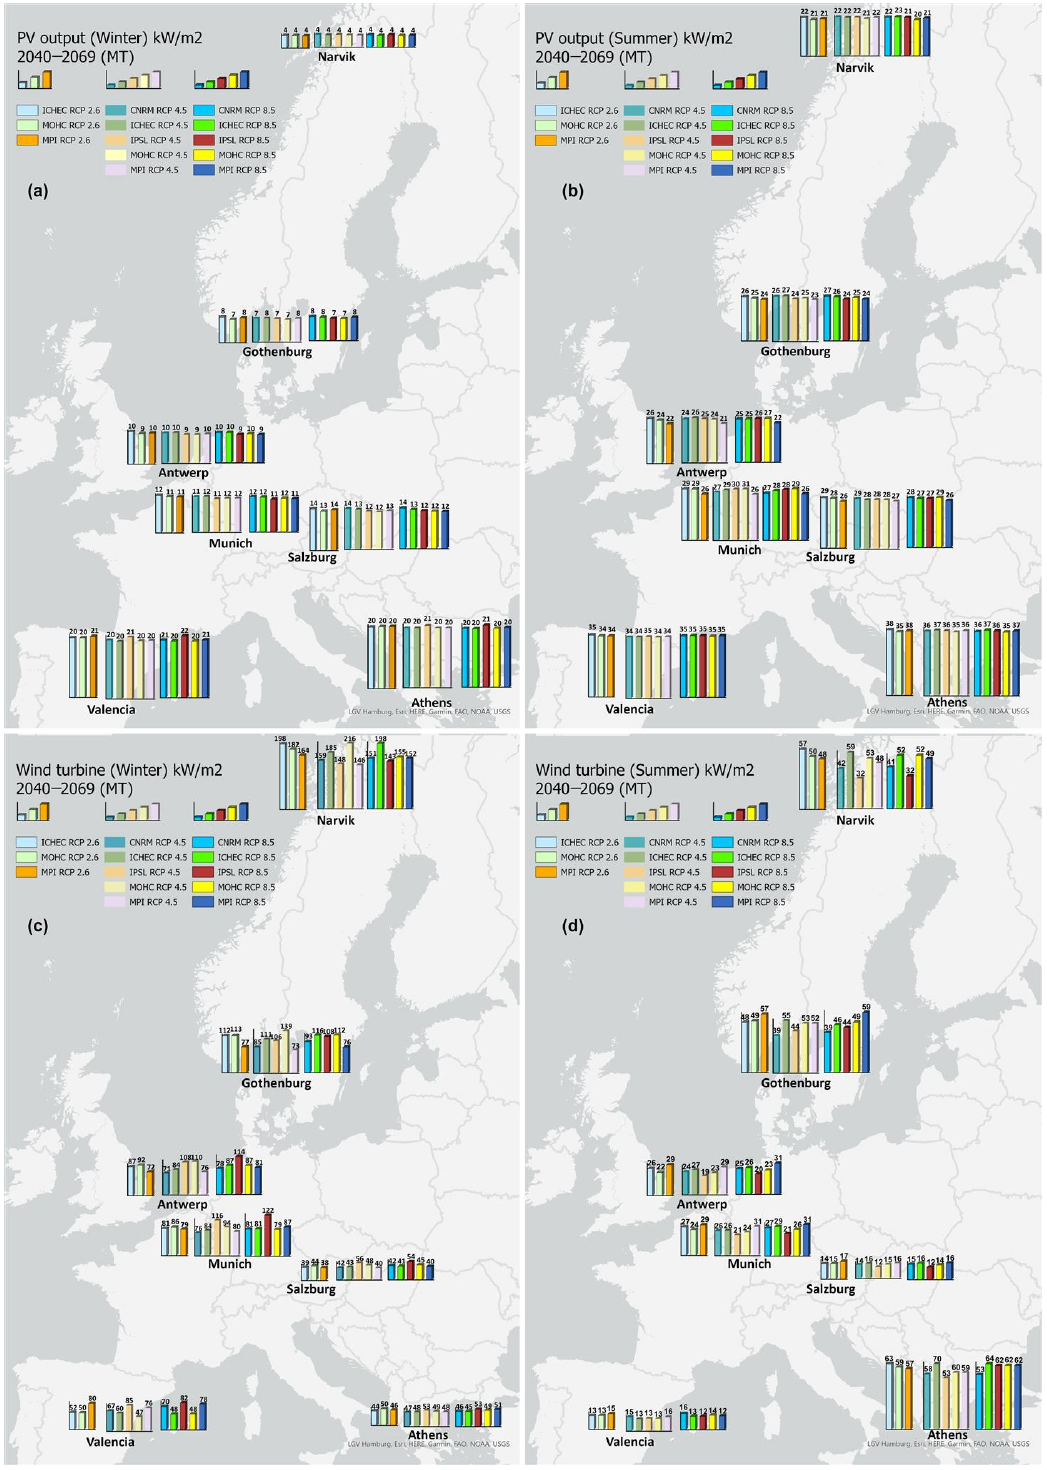
Figure 5. Results for 2040–2069 as medium term (MT) out of 13 climate scenarios: ( a ) winter wind turbine output, ( b ) summer wind turbine output, ( c ) winter PV output, ( d ) summer PV